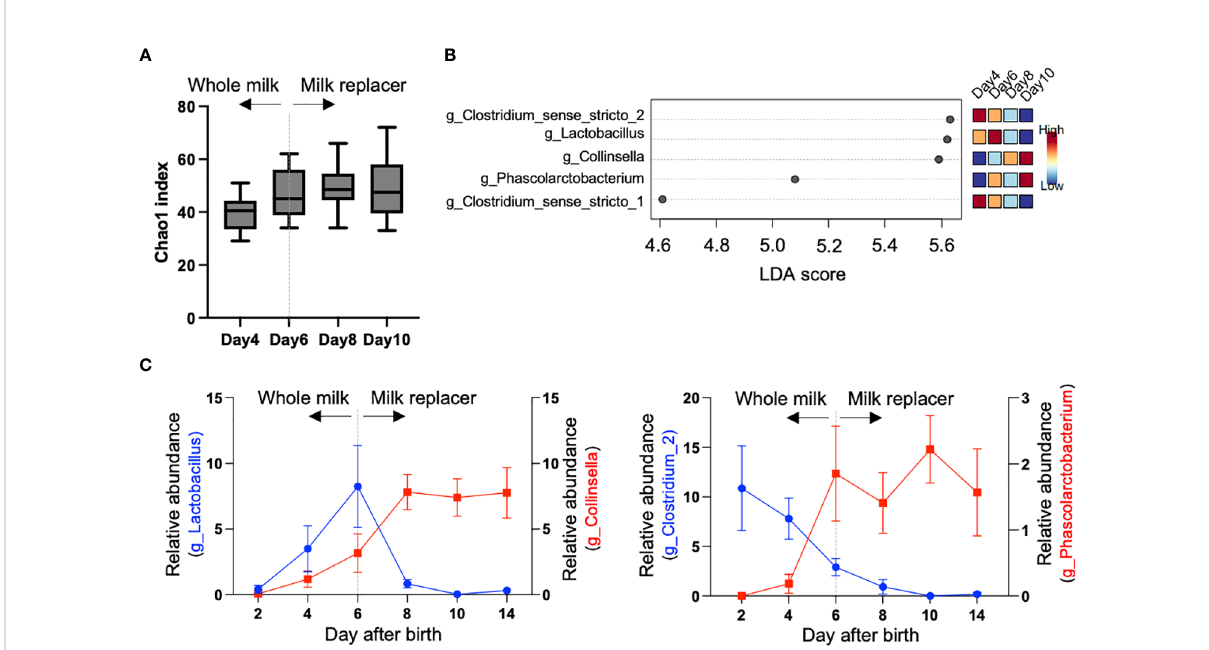
FIGURE 2 Changes of speci fi c bacteria during milk transition. (A) Chao1 index of alpha diversity during milk transition ( n = 10). All calves were switched from whole milk from their mother to a milk replacer on day 6. (B) Speci fi c genera identi fi ed by linear discriminant analysis effect size (LEfSe). The colored boxes on the right indicate the relative abundance of the corresponding genera each day. (C) Changes of Clostridium_sense_stricto_2 , Lactobacillus , Collinsella , and Phascolarctobacterium during milk